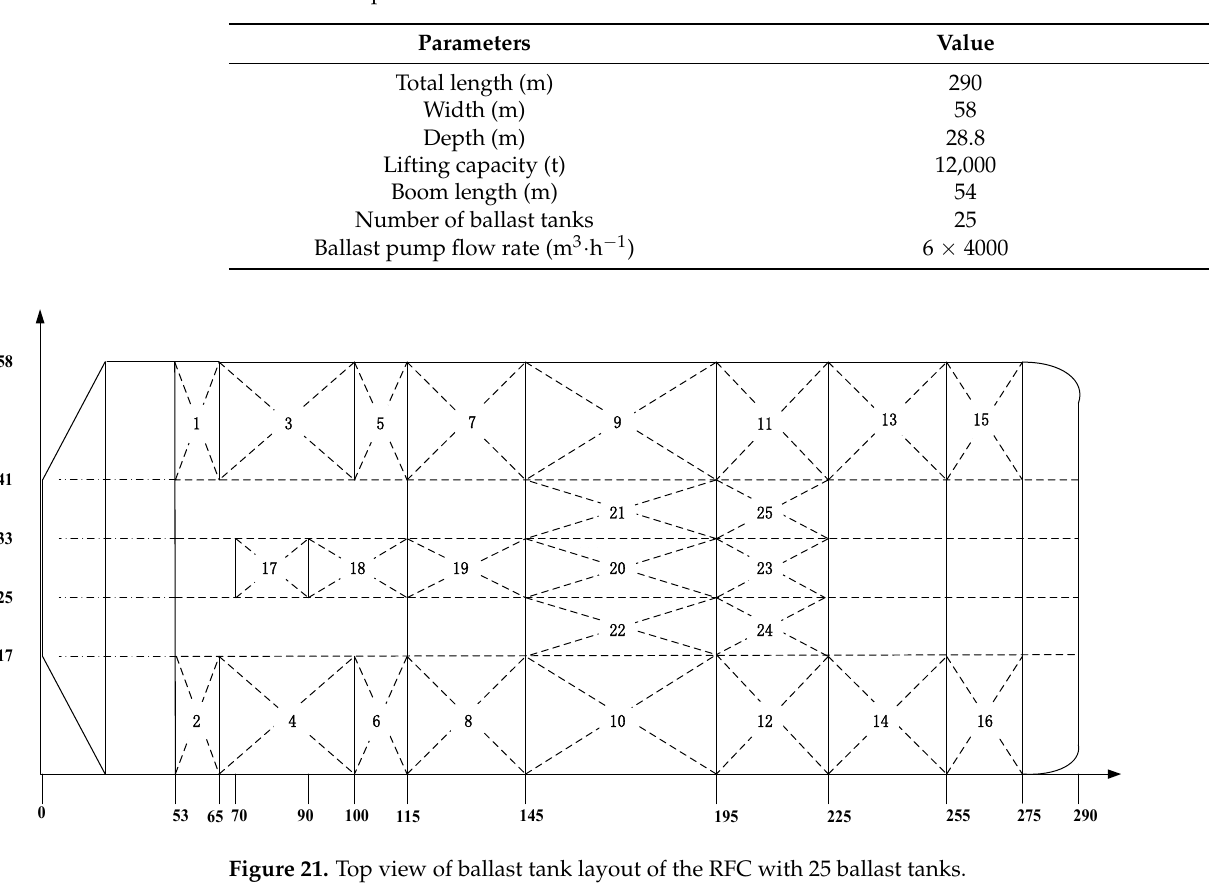
Table 6. Calculation results of different solving algorithms for the RFC with 25 ballast tanks.